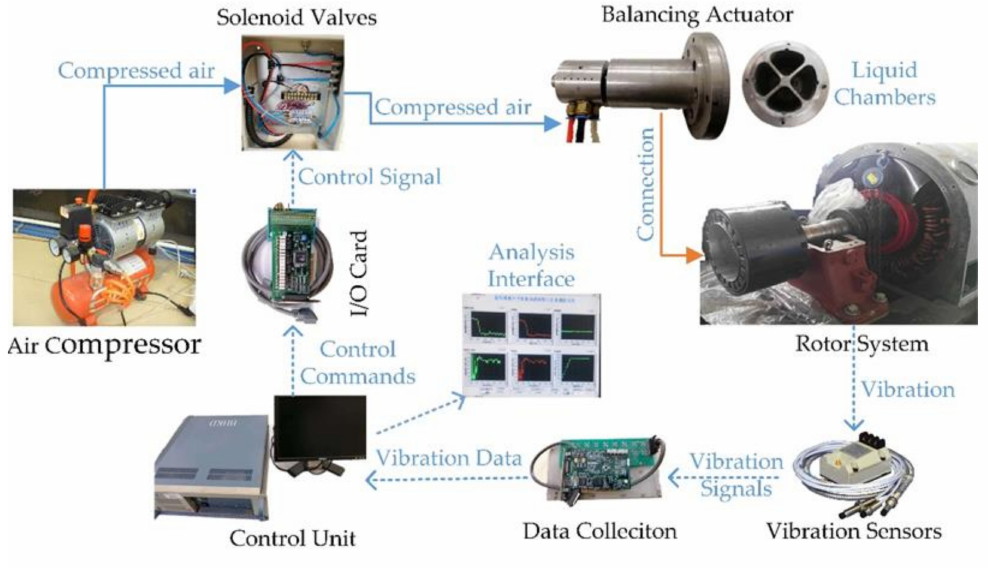
Figure 1. Flowchart of the balancing